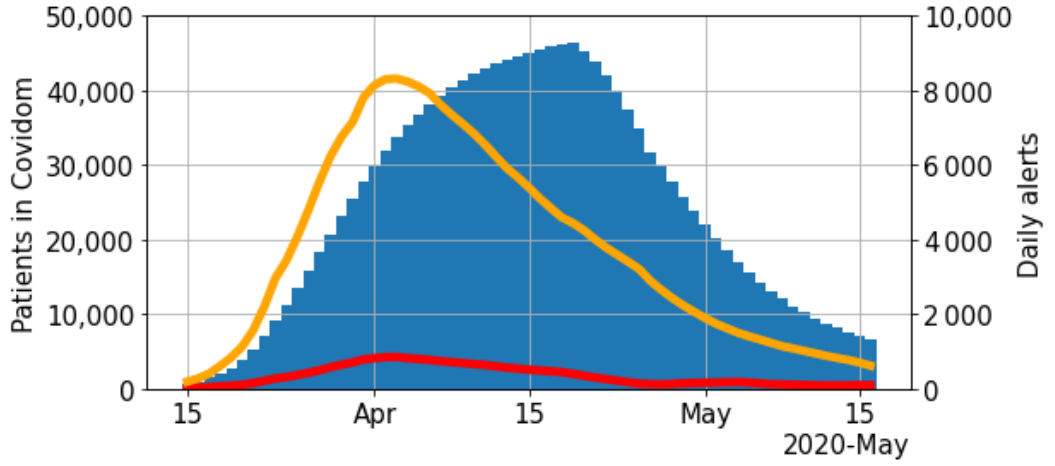
Figure 3. Number of patients and alerts over